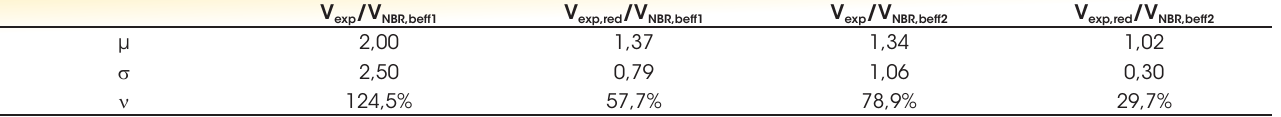
Comparison of results using ABNT NBR 6118 [11]